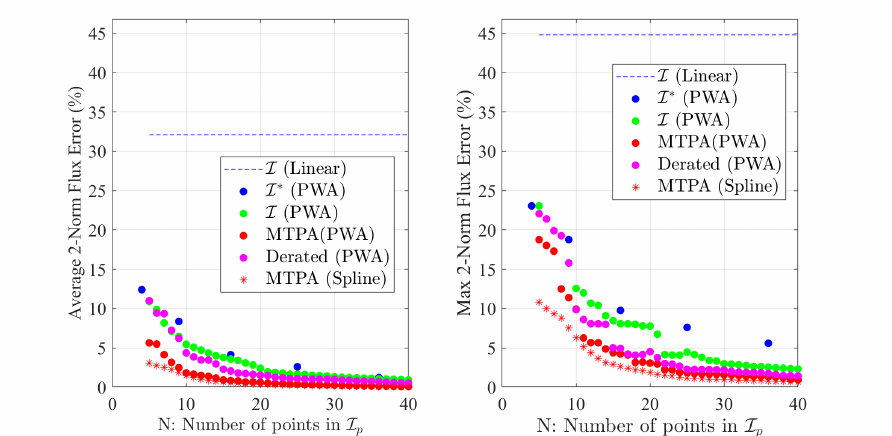
Figure 11. ( left ) Average and ( right ) maximum two-norm flux error vs. N points in various magnetic models (MMs): PWA f PWA ( i ) (targeting error reduction in specific regions), linearized inductance model f l ( i ) , and spline model f s ( i ) (targeting error reduction in MTPA region).